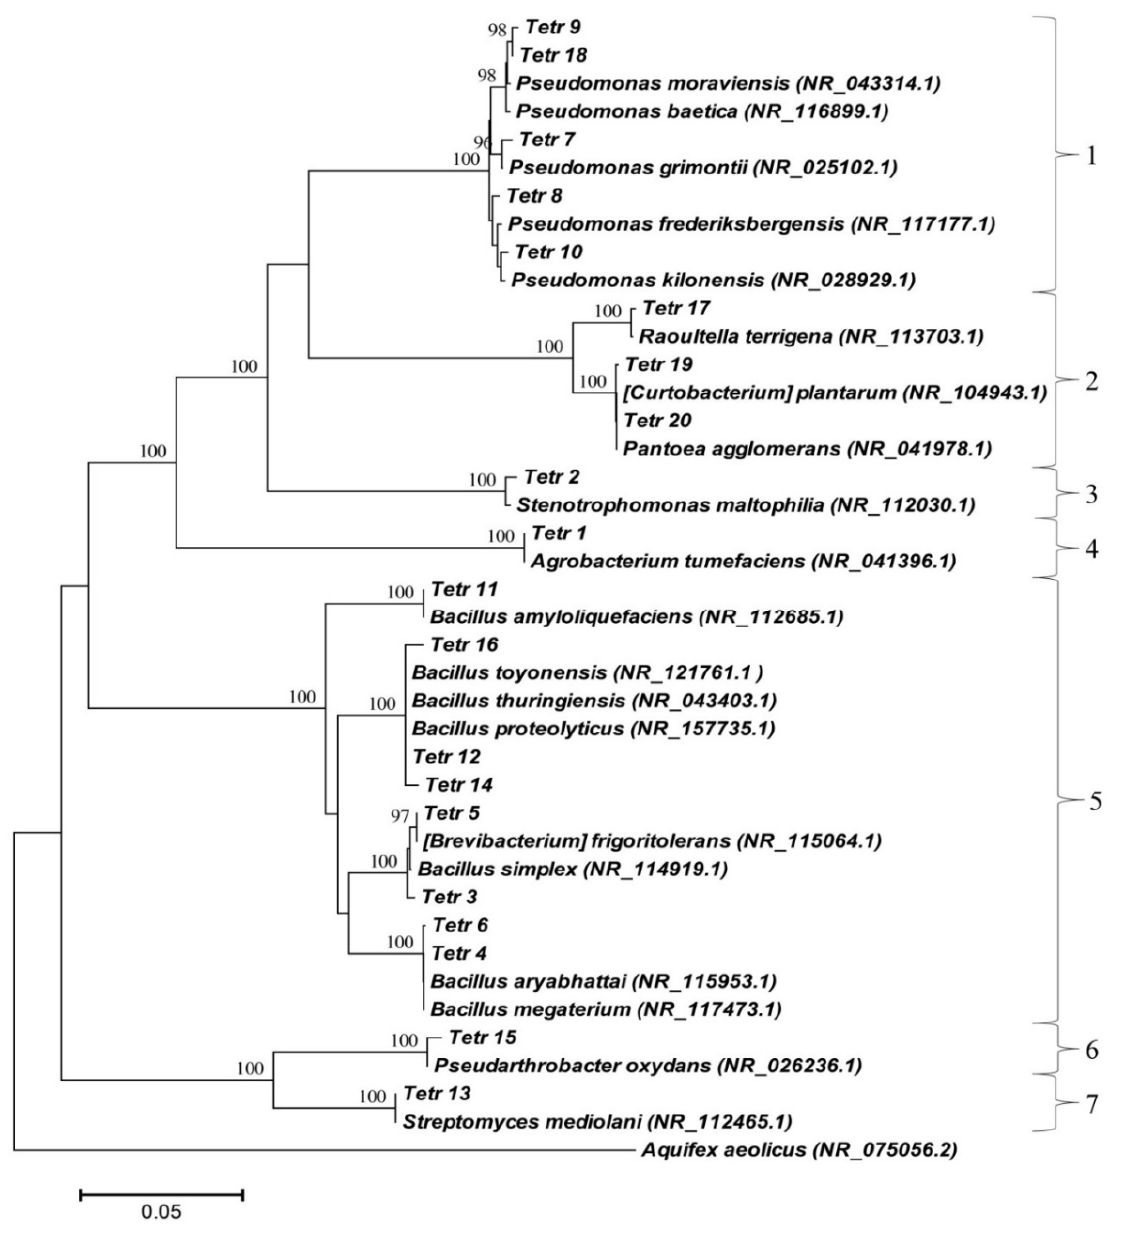
Figure 1. Phylogenetic tree of bacteria endophytes isolated from Tetragonia tetragonioides (Pall.) O. Kuntze and their closest relatives from GenBank. The isolates are divided into seven clusters representing orders: 1—Pseudomonadales, 2—Enterobacterales, 3—Xanthomonadales, 4—Hyphomicrobiales, 5—Bacillales, 6—Micrococcales, 7—Streptomycetales.